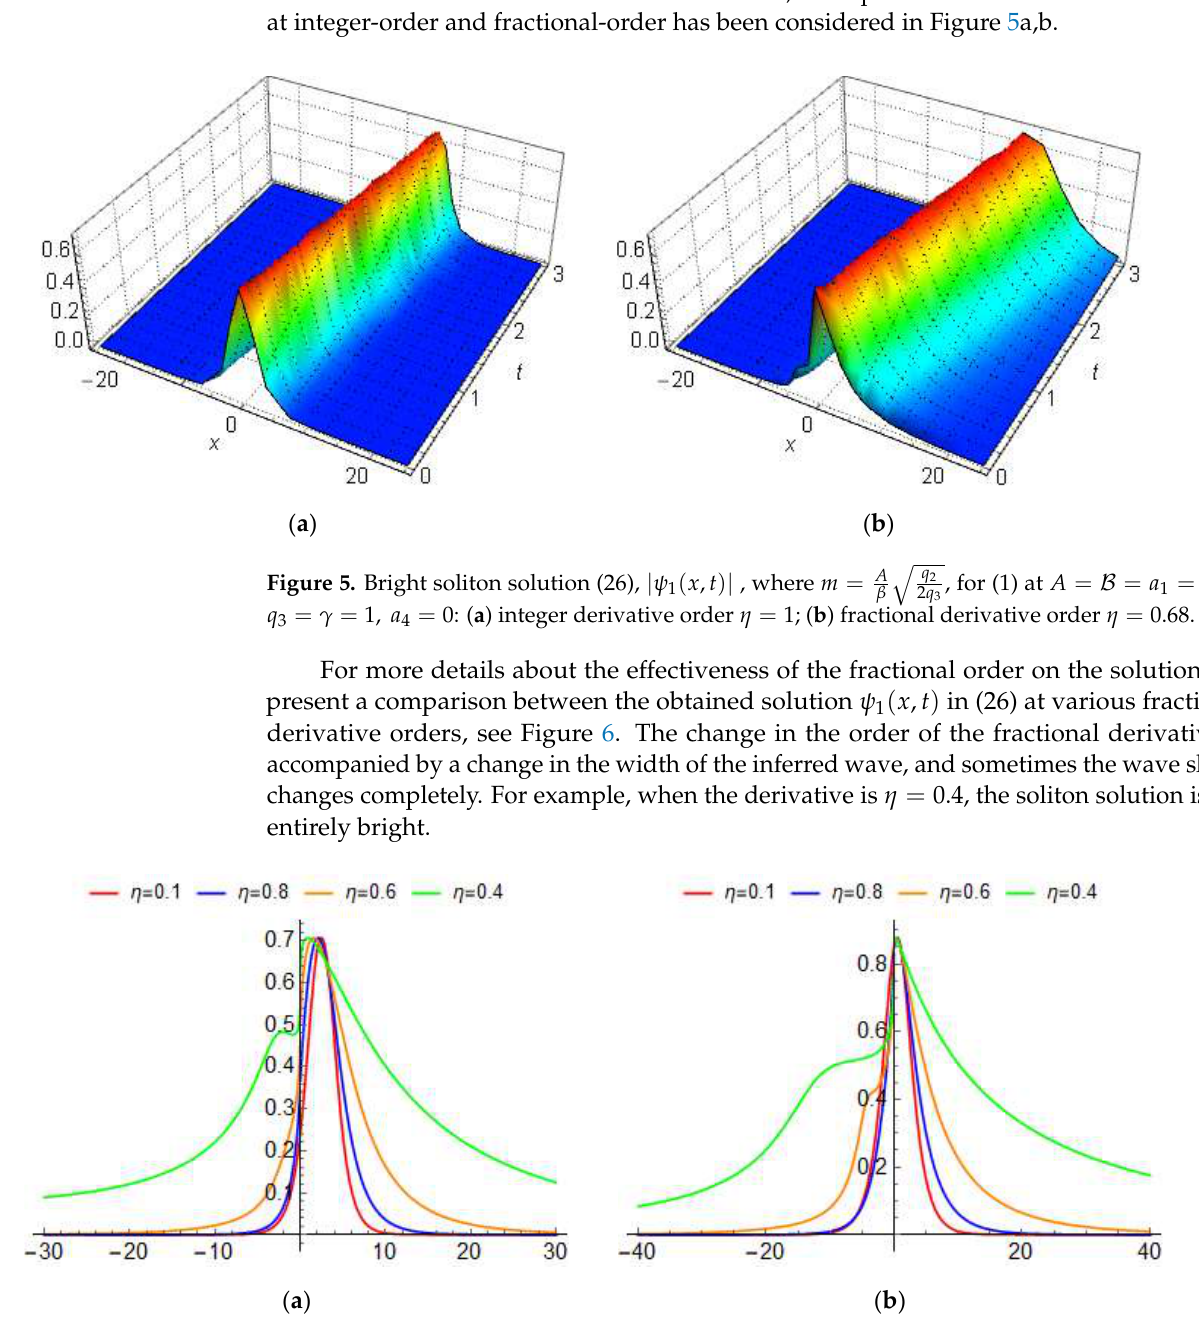
(cid:113) q (cid:3002) (cid:3044) (cid:3118) 2 Figure 6. Bright soliton solution (26), |𝜓 (cid:2869) (𝑥,𝑡)| , where 𝑚 = , for (1) at: ( a ) 2D plot where 𝑡 = Figure 6. Bright soliton solution (26), | ψ 1 ( x , t ) | , where m = A , for (1) at: ( a ) 2D plot where (cid:3495) 2 q 3 β (cid:3081) (cid:2870)(cid:3044) (cid:3119) t = 5, A = B = a 1 = 1, q 2 = 1.8, q 3 = 1.3, γ = 0.5, a 4 = 0; ( b ) 2D plot where t = 1, A = 1, 5,𝒜 = ℬ = 𝑎 (cid:2869) = 1,𝑞 (cid:2870) = 1.8,𝑞 (cid:2871) = 1.3,𝛾 = 0.5,𝑎 (cid:2872) = 0 ; ( b ) 2D plot where 𝑡 = 1, 𝒜 = 1, ℬ = 0.3,𝑎 (cid:2869) = B = 0.3, a = 1, q = 0.8, q = 1.3, γ = 0.5, a = 1,𝑞 (cid:2870) = 0.8,𝑞 (cid:2871) = 1.3,𝛾 = 0.5,𝑎 (cid:2872) = 0. 2 3 1 4